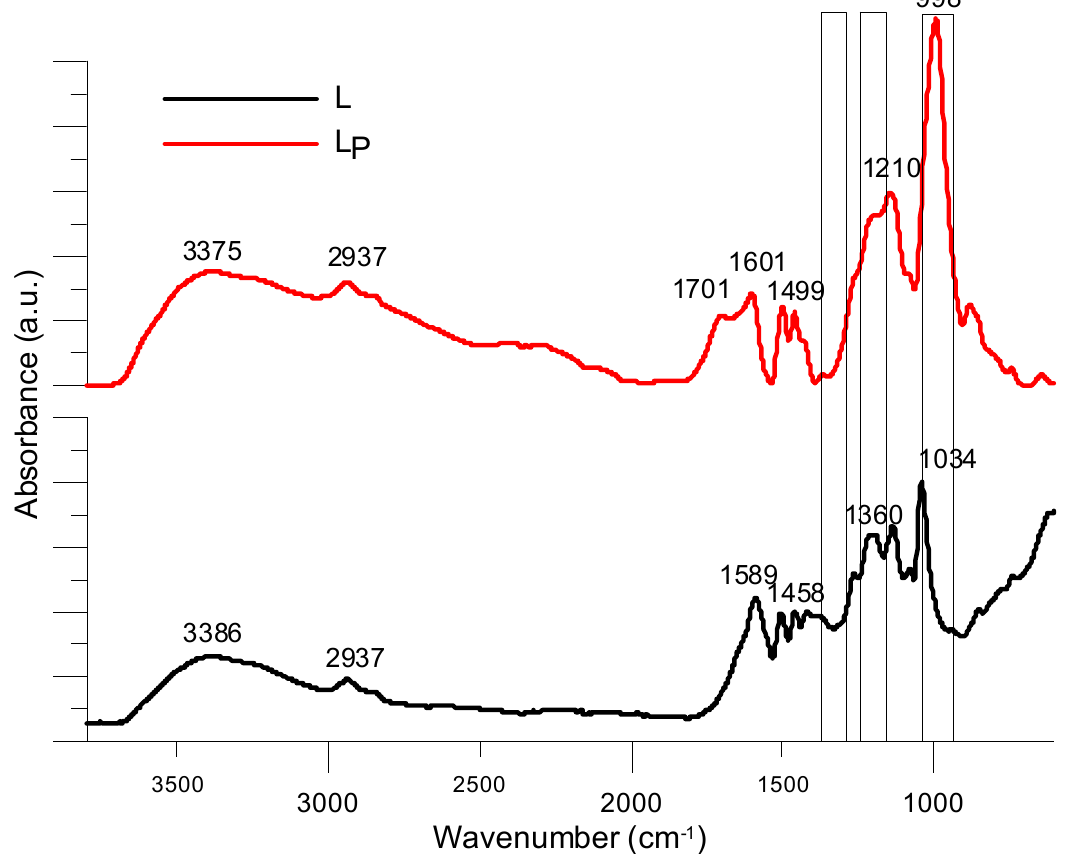
Figure 4. ATR-FTIR spectra of kraft lignin and phosphorylated lignin.